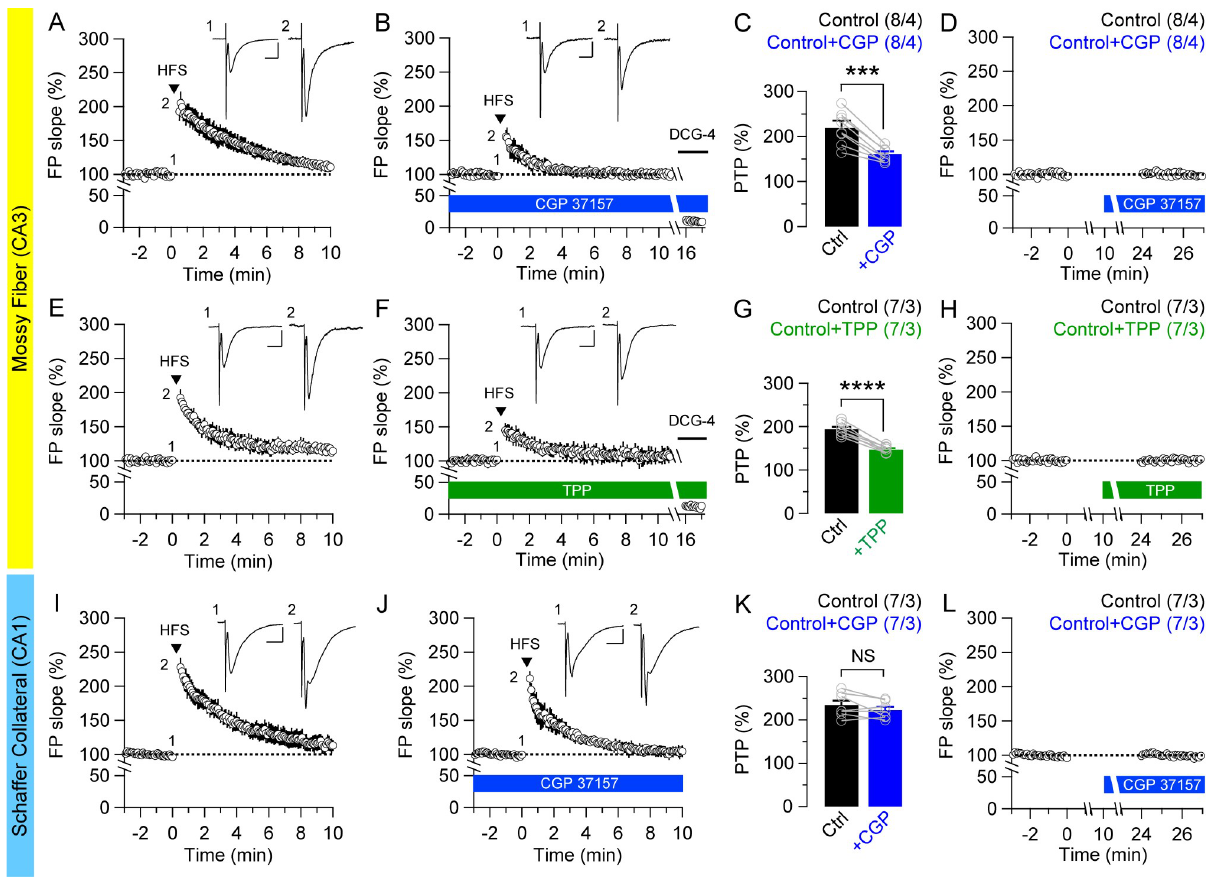
Fig 2. Differential effects of mitochondiral NCX inhibitors on PTP at MF and SC synapses. PTP was induced by high frequency stimulation (HFS: 16 pulses at 100 Hz, 4 times delivered at 0.33 Hz) in acute hippocampal slices of wild-type mice at 2 months of age. ( A & B ) Mean value of time- dependent changes in the fEPSP slope was recorded in the absence (A) or presence (B) of CGP37157 (20 μ M), a mitochondrial NCX inhibitor, in the hippocampal MF pathway. The insets represent traces recorded before and immediately after HFS. DCG-4 (2 μ M) was applied at the end of all experiments to confirm the recording of MF synapses. ( C ) The summary bar graph for the mean magnitude of PTP shows that PTP is reduced by CGP37157 treatment at MF synapses (Control: 219.1 ± 12.0%; +CGP: 157.1 ± 5.2%; p = 0.00013, paired t -test). ( D ) The effect of CGP37157 on basal transmission. Treatment of CGP37157 for 15 min has no effect on the fEPSP slope at MF synapses. ( E & F ) Mean value of time-dependent changes in the fEPSP slope was recorded in the absence (E) or presence (F) of TPP + (2 μ M), another specific inhibitor of mitochondrial NCX, in the hippocampal MF pathway. ( G ) The summary bar graph for the mean magnitude of PTP further shows that PTP induction is reduced at MF synapses (Control: 194.0 ± 5.2%; +TPP: 147.2 ± 2.7%; p < 0.0001, paired t -test). ( H ) The effect of TPP + on basal transmission. Treatment of TPP + for 15 min has no effect on the fEPSP slope at MF synapses. ( I & J ) Mean value of time-dependent changes in the fEPSP slope before and after the PTP induction in the hippocampal SC pathway. The insets represent traces recorded before and immediately after HFS. The effect of treatment with CGP37157 on PTP of fEPSPs at the hippocampal SC pathway shows that inhibition of mitochondrial Ca 2+ release had no effect on PTP induction. ( K ) The summary bar graph for the mean magnitude of PTP shows that PTP induction is not different at SC synapses in the absence or the presence of CGP37157 treatment (Control: 234.7 ± 9.8%; +CGP: 222.7 ± 6.9%; p = 0.17, paired t -test). ( L ) The effect of CGP37157 on basal transmission. Treatment of CGP37157 for 15 min has no effect on the fEPSP slope at SC synapses. All data represent mean ± SEM ( ��� p < 0.001, ���� p < 0.0001, NS: not significant; Student’s t